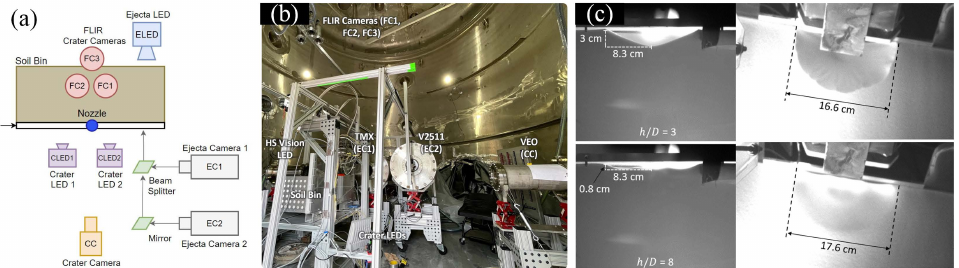
Figure 24. Plume–Lunar Lunar/Mars regolith interaction test performed by NASA. ( a ) Top view schematic of the diagnostic system [173]. ( b ) The corresponding diagnostic system inside the vacuum chamber [172]. ( c ) The captured crater from the side and top views [172].